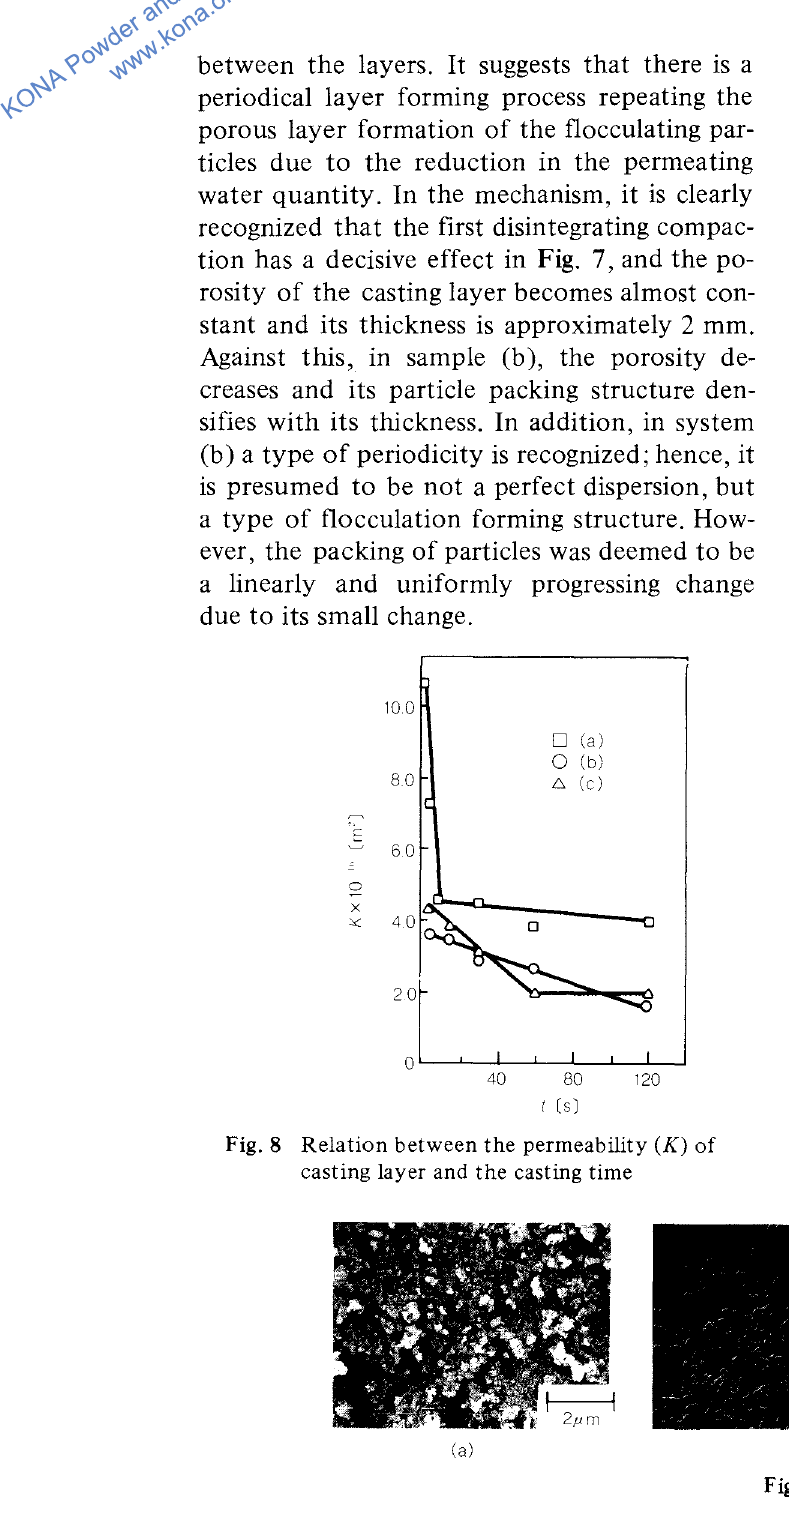
Fig. 8 Relation between the permeability (K) of casting layer and the casting time